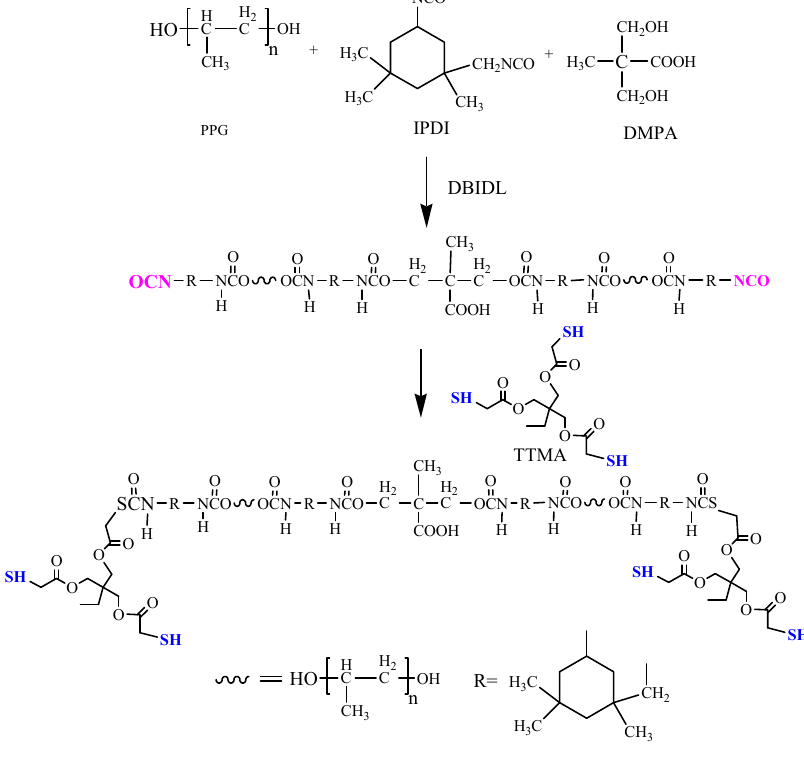
Figure S1. The characteristics absorption at 2530–2590 cm no characteristic absorption of isocyanate group and OH of polyether in the range of 2260–2280 cm − 1 and 3500 cm respectively, which denotes that the isocyanate group and -OH reacted completely.